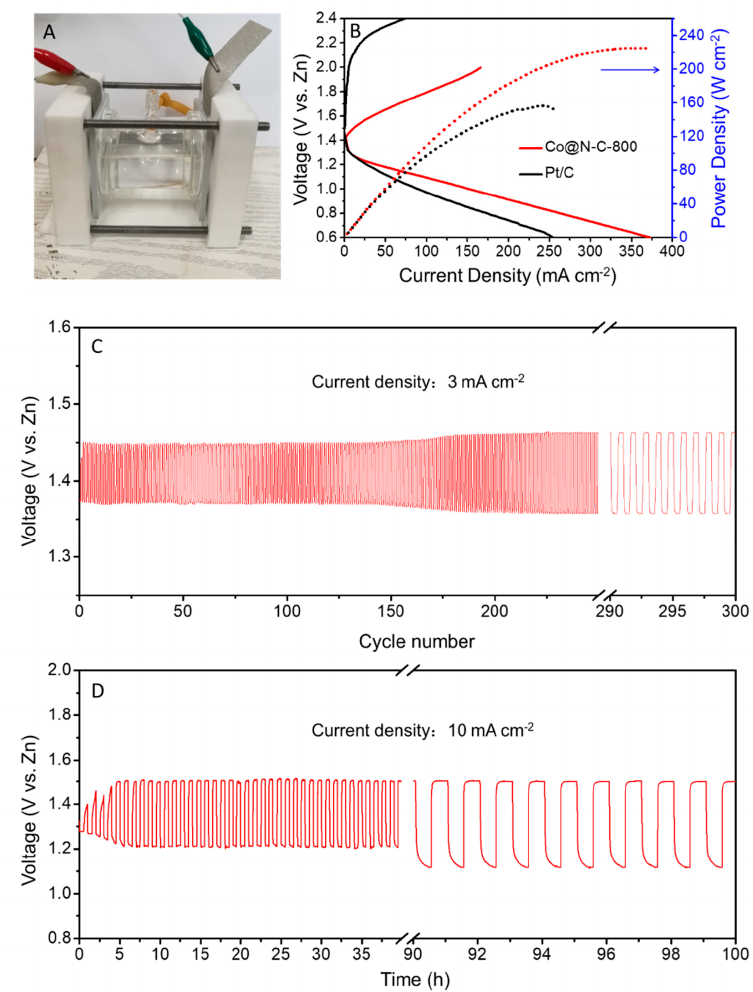
Figure 7. The performances of Zn-air battery with Co@N-C-800 or Pt/C as air cathode. ( A ) The illustration of the home-made Zn-air battery device, ( B ) charge/discharge polarization profiles and power density curves of the batteries, ( C ) a fast charge-discharge cycling test of the battery using Co@N-C-800 catalyst at current density of 3 mA cm − 2 in a total of 300 cycles, and ( D ) a long-term change-discharge test of the batteries with Co@N-C-800 catalyst in 100 h cycle period at 10 mA cm − 2 (1 h per cycle).